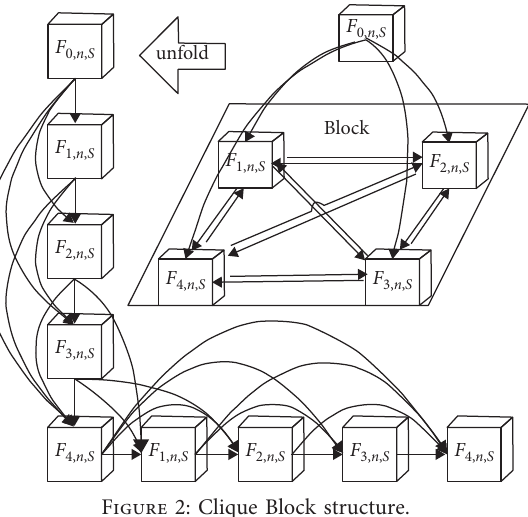
Figure 2: Clique Block structure.